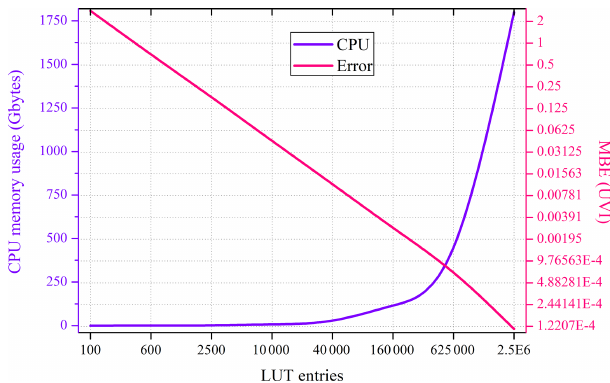
Figure 2. UVIOS memory usage and error statistics in terms of mean bias error (MBE) for a range of different LUT